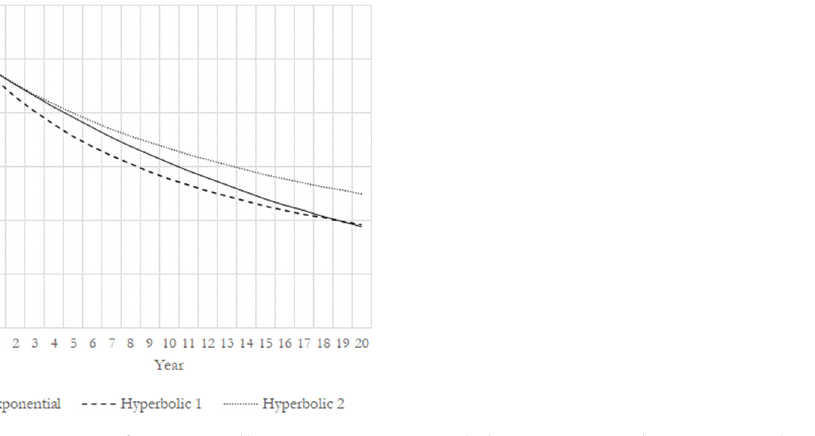
Figure 17. Discount functions, illustrating exponential discounting with i E = 0.05, hyperbolic discounting with i H = 0.08, and hyperbolic discounting with i H = 0.05 .